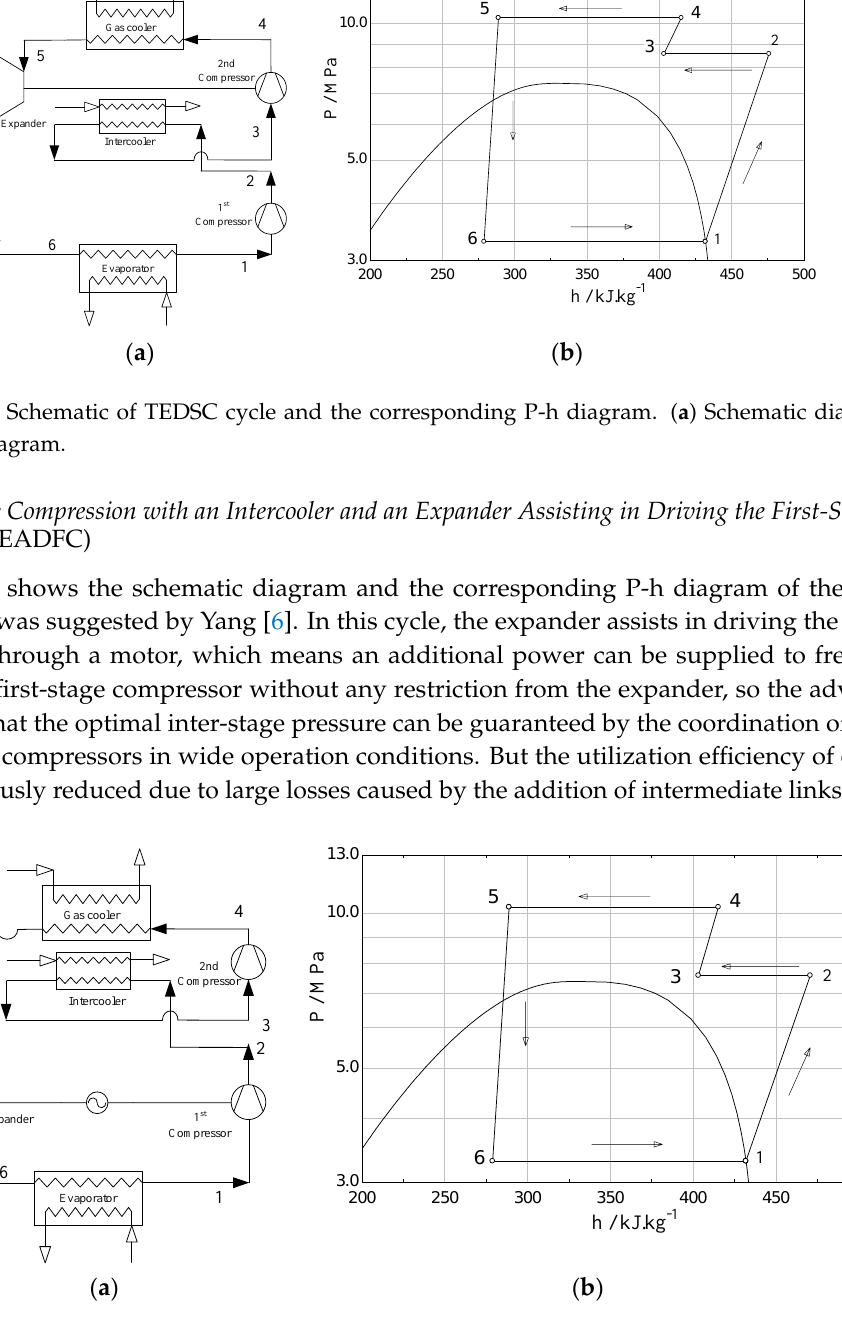
( b ) Figure 1. Schematic of SE cycle and the corresponding P-h diagram. ( a ) Schematic diagram; ( b ) P-h diagram. 2.2. Two-Stage Compression with an Intercooler and an Expander Driving the Second-Stage Compressor (TEDSC) The use of two-stage compression cycle with an intercooler is an efficient measure to improve the cycle COP by decreasing the irreversible losses in the compression process [21]. Replacing the throttling valve with an expander for power recovery can further improve the cycle COP significantly owing to the decreased irreversible losses in the throttling process. To effectively utilize the work extracted from the expansion process, the compressor should be coupled with the expander directly. JL Yang’s researc h results showed that the COP of two-stage compression cycle with an expander to drive the low-pressure compressor was smaller than to drive the high-pressure compressor, even smaller than that of SE cycle [6]. Therefore, the two-stage cycle with an intercooler and an expander driving the second-stage compressor (TEDSC) is usually adopted [8]. The schematic and corresponding P-h diagrams of TEDSC cycle are shown in Figure 2. To avoid CO 2 refrigerant from leaking to external environment and reduce transmission losses of expansion work, the expander and the second-stage compressor were usually combined into one unit by a common shaft, like as the prototypes developed by Nickl et al. [8] and Zhang et al. [9]. Therefore,